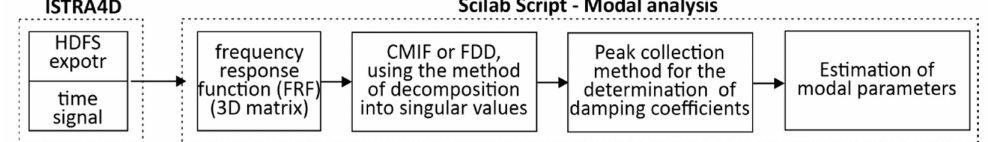
Figure 8. Processing of exported measurement data in